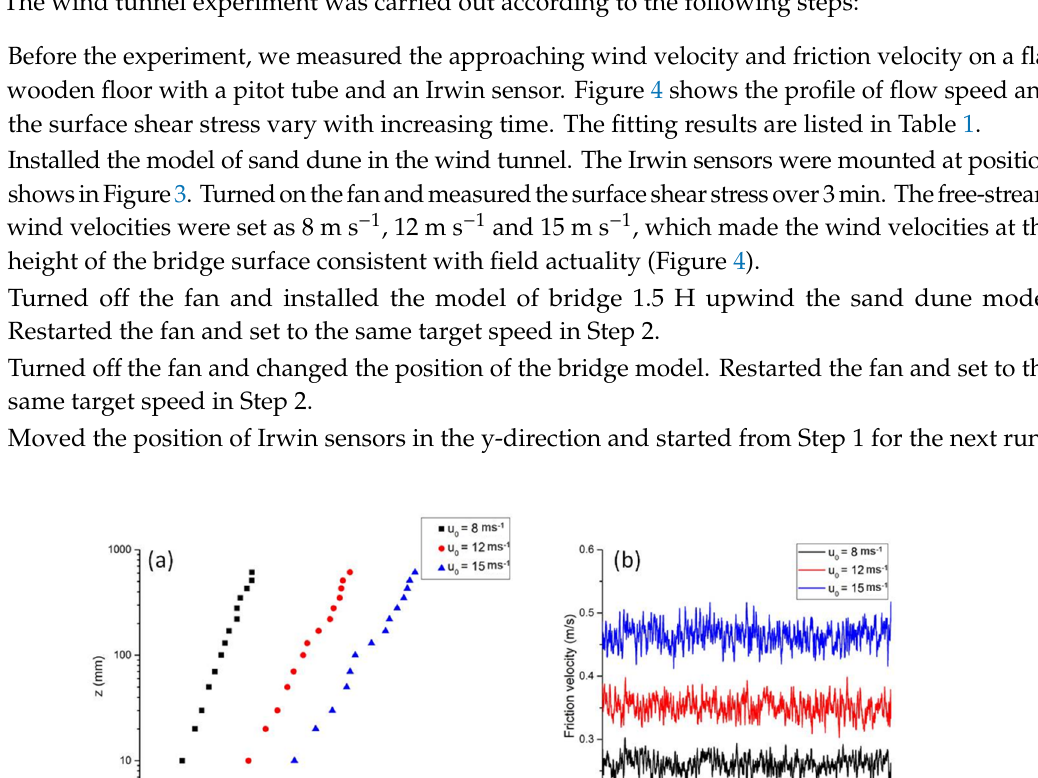
Figure 4. The data of wind field in wind tunnel without models: ( a ) vertical distribution of time- averaged wind velocity measured by Pitot-static tubes with different 0 u and ( b ) fluctuations of friction velocity measured by Irwin sensor with different 0 u .